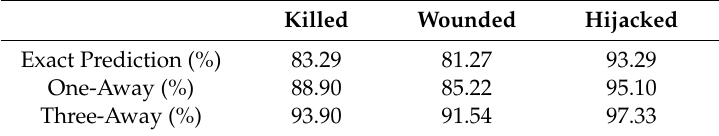
Table 4. Percentage of correct prediction of security events in